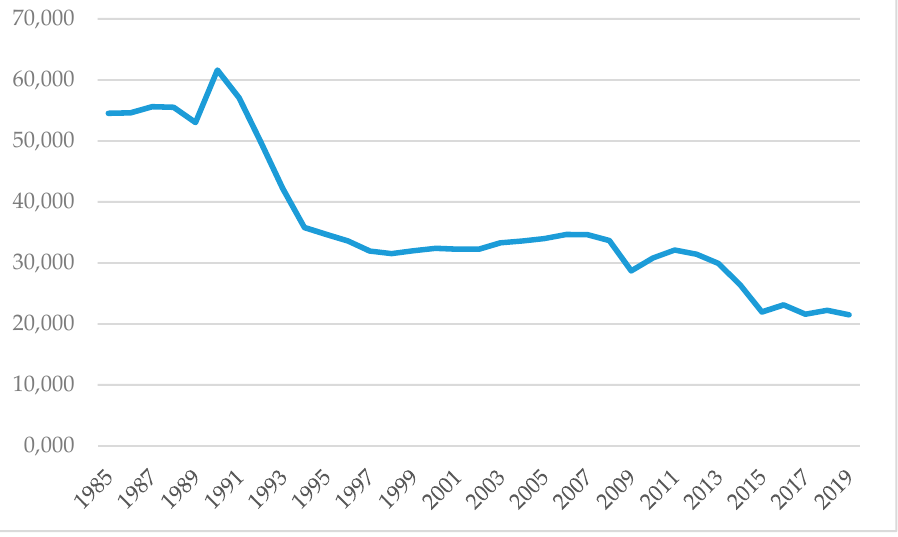
Figure 4. Energy consumption per capita (kWh) in Ukraine (according to the data source [14]).